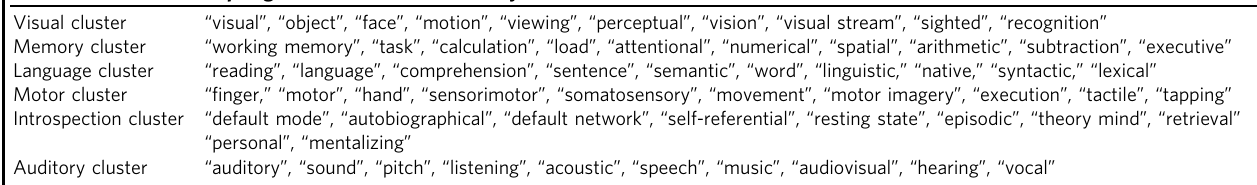
Table 1 Top cognitive factors related to each task cluster. Top cognitive factors in the neurosynth